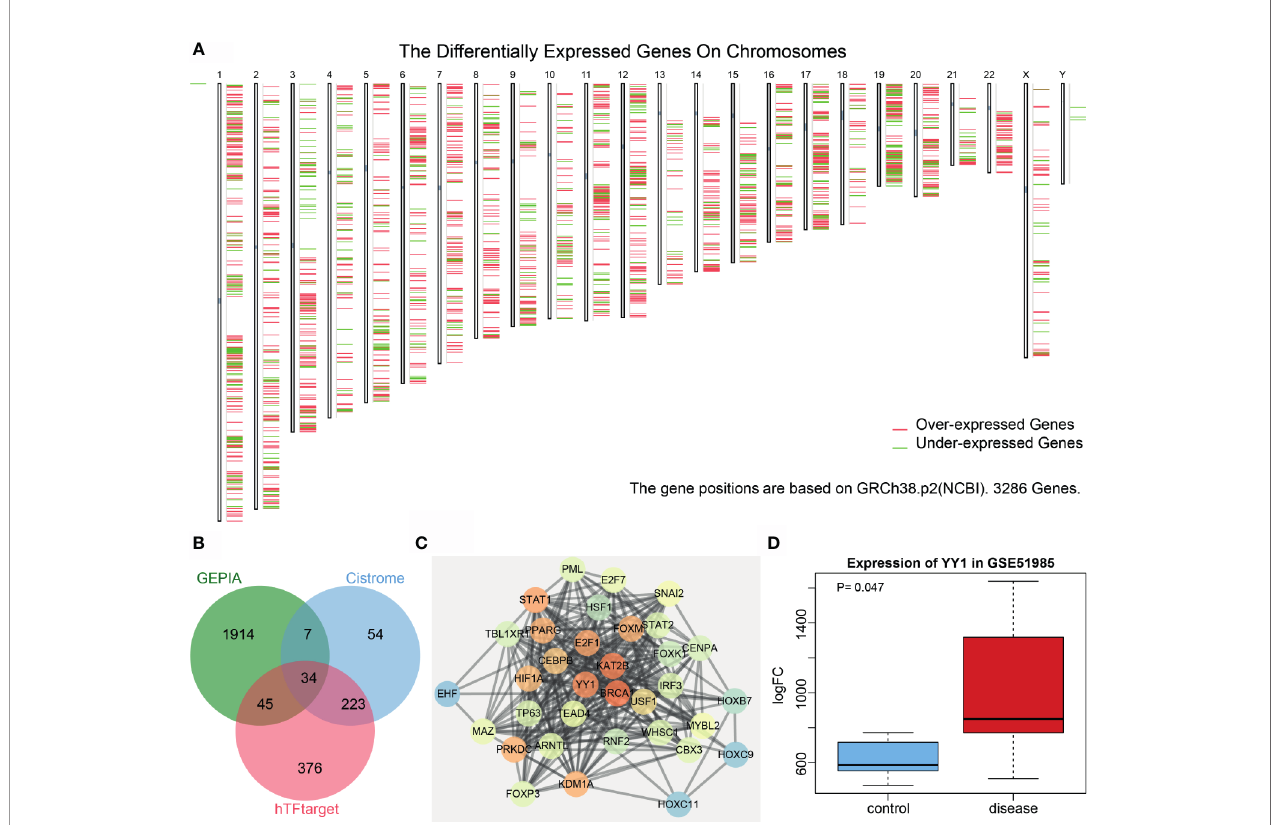
FIGURE 1 | Bioinformatics analysis of the signi fi cance of YY1 in LSCC. (A) A heatmap of the expression of the fi rst 2,000 differentially expressed genes in each chromosome in LSCC samples from the TCGA database using the GEPIA tool. Red indicates highly expressed genes, and green indicates poorly expressed genes; from the left to the right, there are chromosomes 1 – 22 and sex chromosome. (B) Venn diagram analysis of LSCC-related differentially expressed genes obtained from GEPIA and human transcription factors obtained from hTFtarget and Cistrome. (C) Protein interaction network of 34 intersected transcription factors constructed by String. The higher core degree of the gene re fl ects redder circle, and otherwise, the bluer circle re fl ects lower core degree. (D) A box plot of YY1 expression in the GSE51985 dataset retrieved from the GEO database. Red box represents YY1 expression in LSCC samples and blue box represents YY1 expression in normal